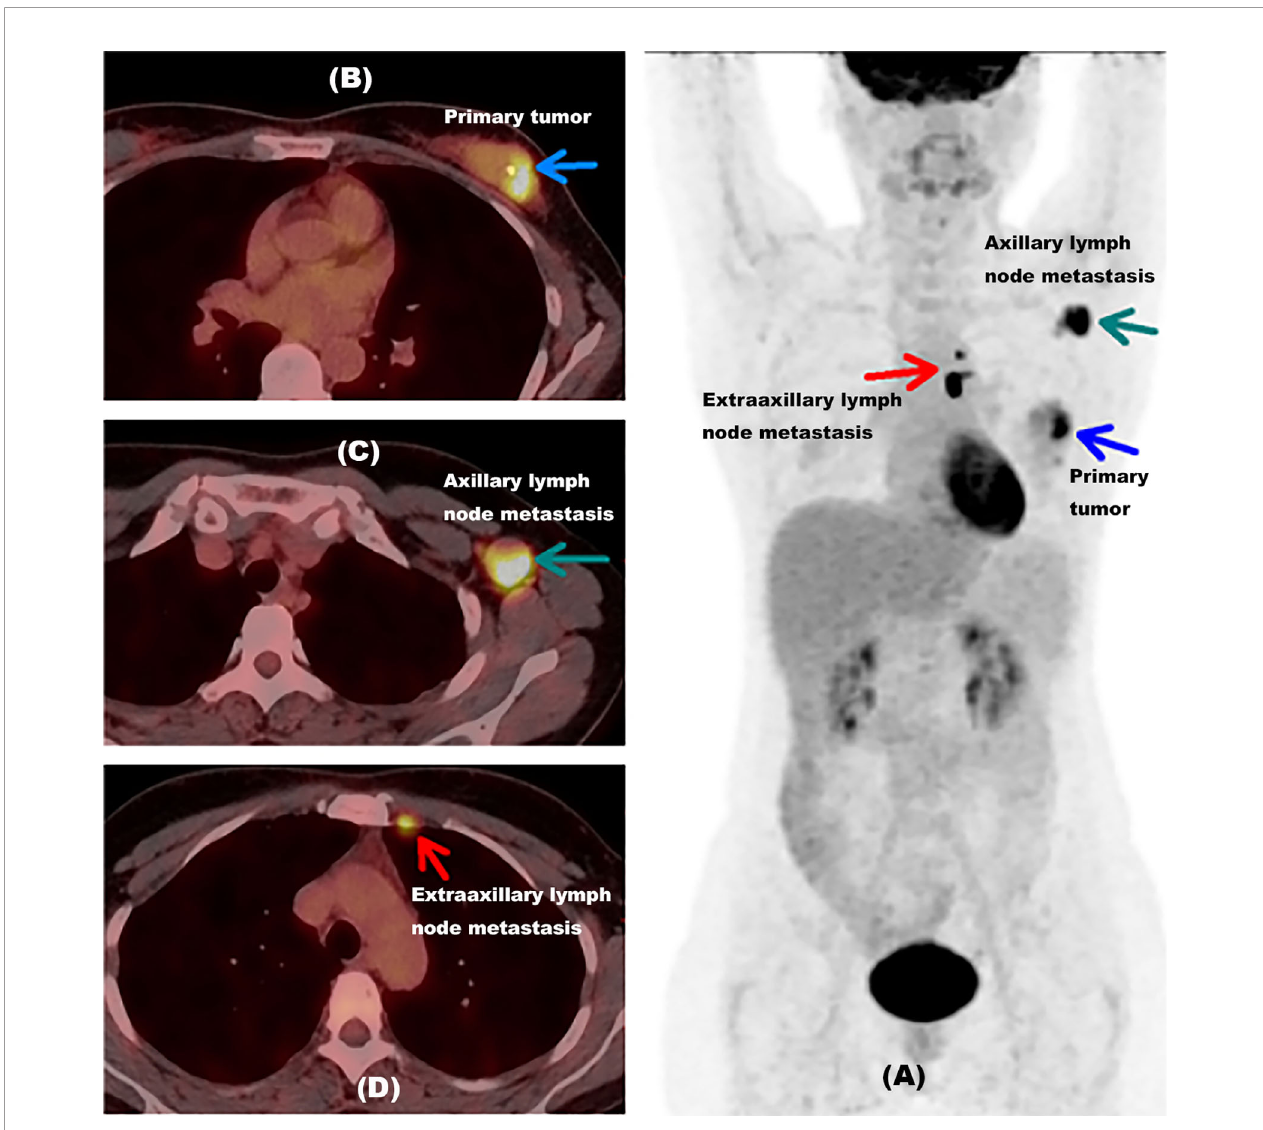
FIGURE 4 | Example for a newly diagnosed breast cancer patient with unsuspected extraaxillary lymph node metastasis detected by 18F-FDG PET/CT inspection. (A) A MIP picture of a 48-year-old newly diagnosed breast cancer woman detected by an 18F-FDG PET/CT inspection with the proportion of ER at 1%. The blue arrow showed the primary tumor of this patient. The green arrow indicated axillary lymph node metastasis in the left armpit. The red arrow presented extraaxillary lymph node metastasis in the left internal mammary near breastbone. (B) PET/CT fusion image of this woman with primary tumor. The blue arrow showed the primary tumor of this patient. (C) PET/CT fusion image of this woman with axillary lymph node metastasis. The green arrow indicated axillary lymph node metastasis in the left armpit. (D) PET/CT fusion image of this woman with extraaxillary lymph node metastasis. The red arrow presented extraaxillary lymph node metastasis in the left internal mammary near the breastbone. ER, estrogen receptor; MIP, maximum intensity projection, with the proportion of ER lower than